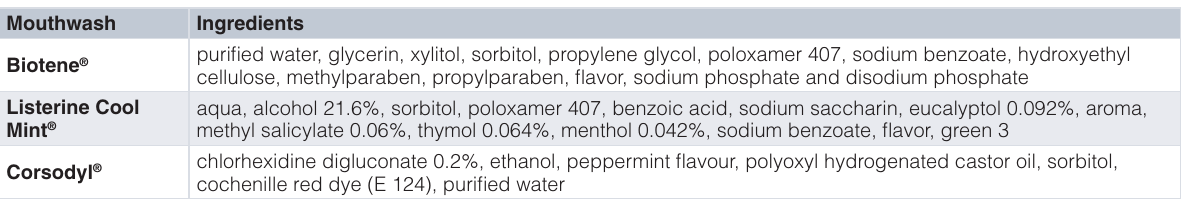
Table 1. Ingredients of the commercially available mouthwashes, according to their product insert. Mouthwash